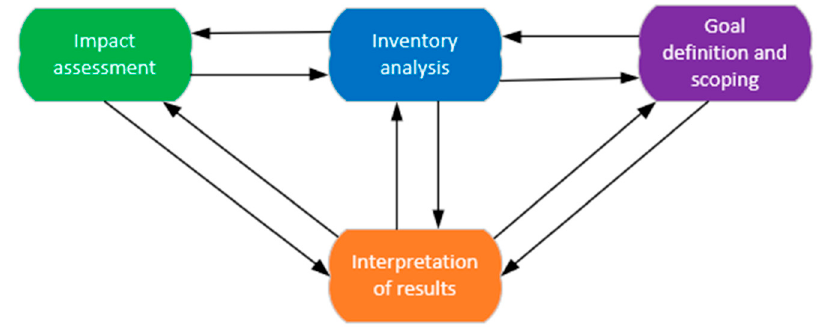
Figure 1. Theoretical framework of life cycle assessment.